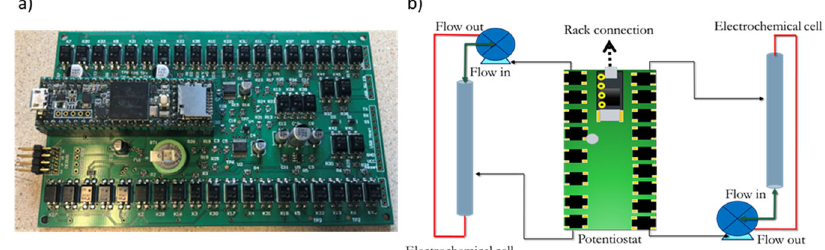
Fig. 6 Autonomous potentiostat. a NuVant Systems Inc. potentiostat printed circuit board with Teensy microcontroller used in the AELISS electrochemical system and b simpli fi ed diagram of the AELISS electrochemical system which includes 12 individual electrochemical cells, an autonomous potentiostat, peristaltic pumps (2), and under triple containment.